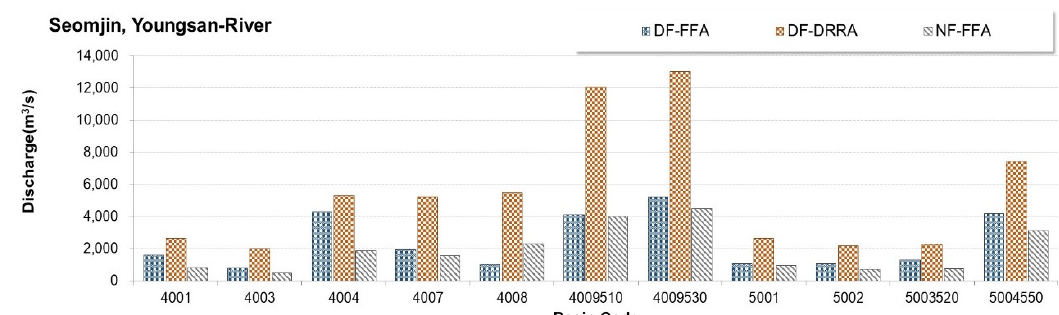
Figure 11. The 100-year design floods of Gum River basin.